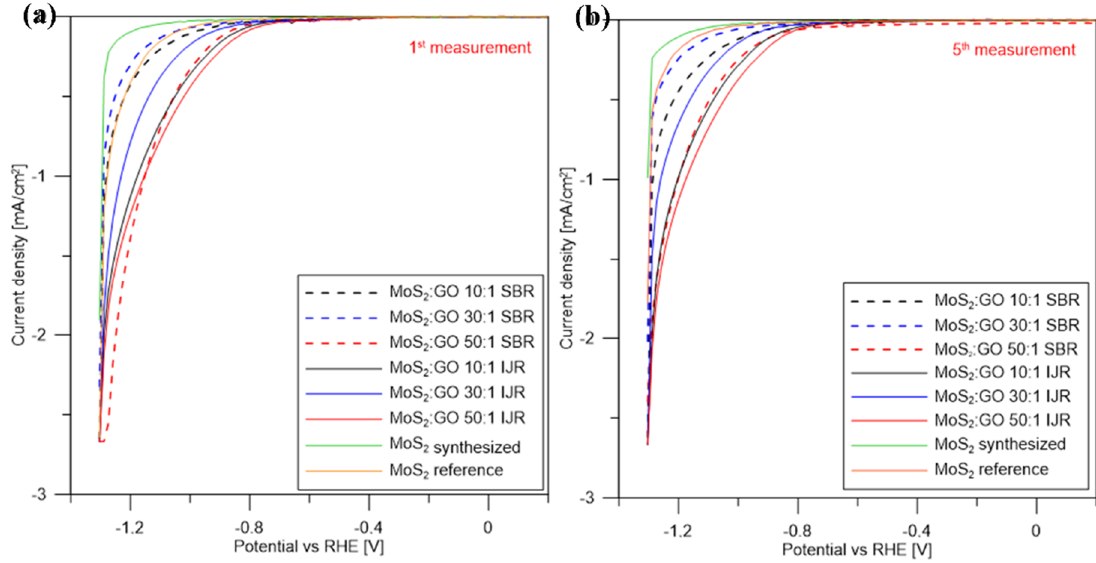
Figure 11. Linear sweep voltammograms of MoS 2 and MoS 2 / GO performed using three electrodes system (Platinum wire as counter electrode and Ag/AgCl as reference electrode) ( a ) the first measurement, ( b ) the fifth measurement.